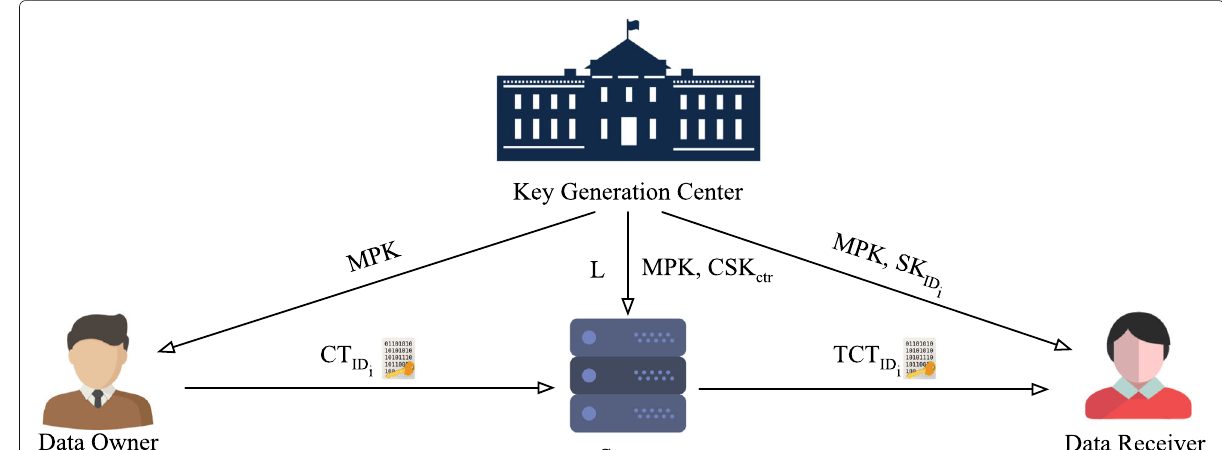
Fig. 1 System model of the proposed server-aided revocation mechanism